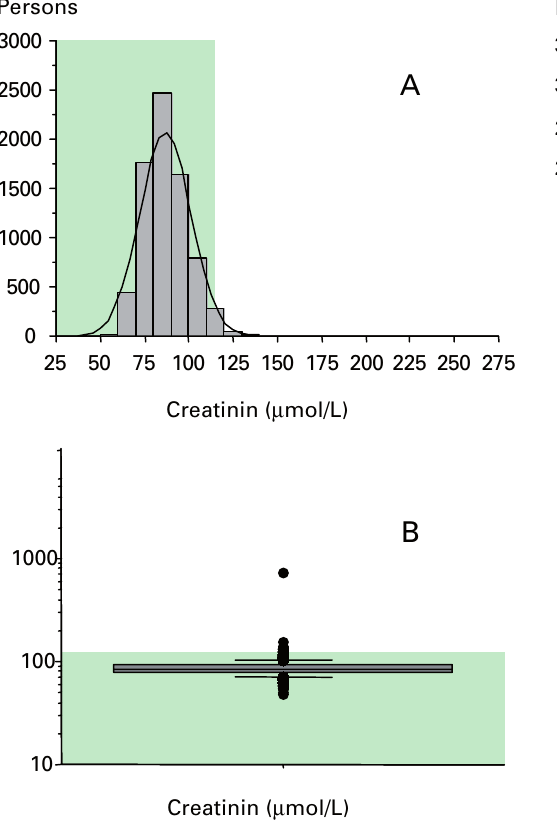
Figure 5 Creatinin: acute or chronic renal insufficiency. Creatinin values were distributed normally (A). 1.8% (136/7484) of draftees showed elevated creatinin values between 115 and 200 m mol/L. One patient presented in terminal renal failure (creatinin 740 m mol/L) and renal anemia (82 G/L, see fig. 3B). The area shaded in green indicates the normal range.